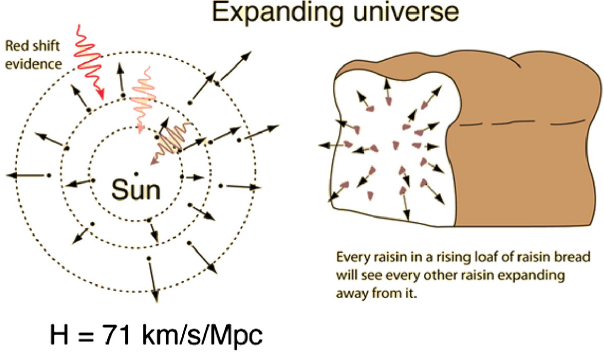
FIG. 20. The expanding Universe representational analogy combining two representations, in the form of a translational move supporting a shift in meaning from spatial links with redshift to raisin bread analogy. Image credit: Georgia State University.